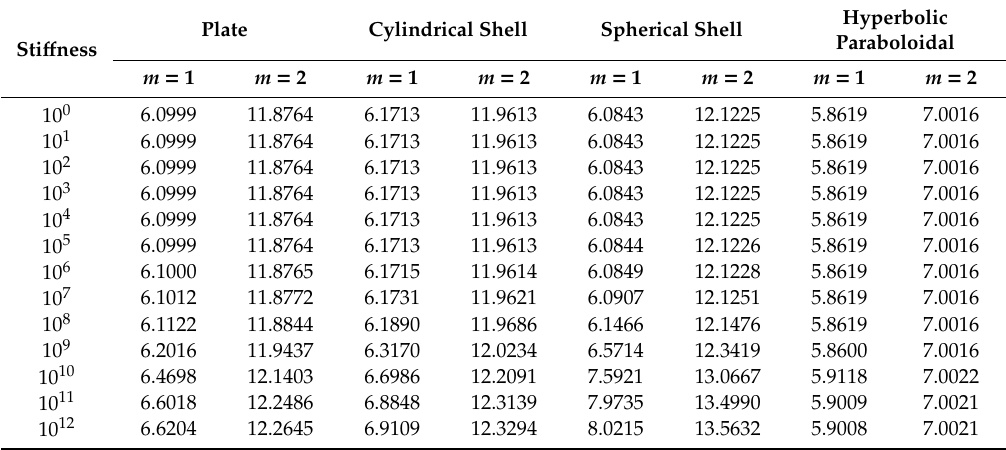
Table 13. The frequency parameter Ω for composite shallow [0 ◦ / 90 ◦ ] shells with S- K v boundary conditions by